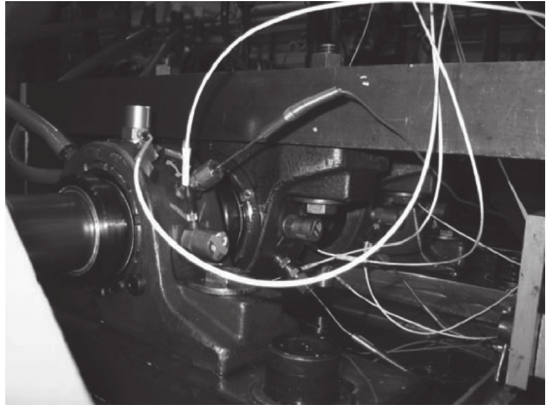
Figure 14: IMS test rig